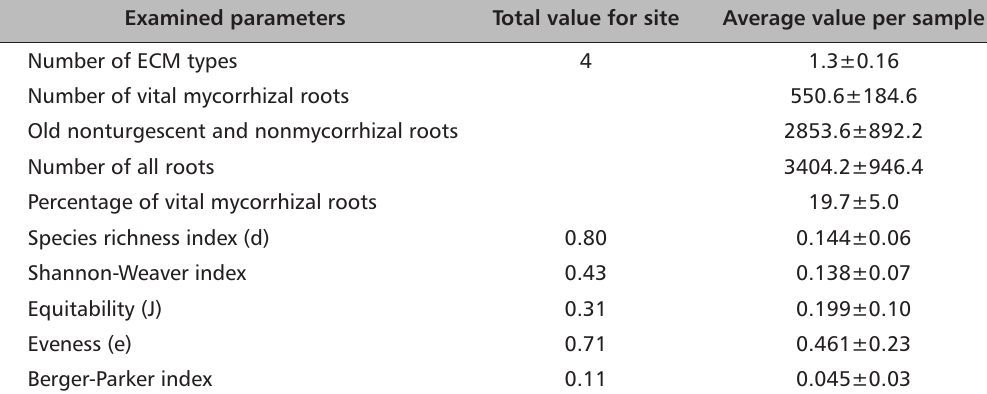
abundant and made up 89.4% of all ECM roots (data not shown). In examined poplar roots no AM fungal structures were observed, while ECM and END fungi colonized 18.19% and 2.23% of root length, respectively (Table TABLE 3. Total values and average values per sample (±standard error) for number of ectomycorrhizal (ECM) types, number of vital ECM roots, old, nonturgescent and nonmycorrhizal roots, number of all roots, percentage of vital mycorrhizal roots and diversity indices on investigated site Timok (based on 10 samples)